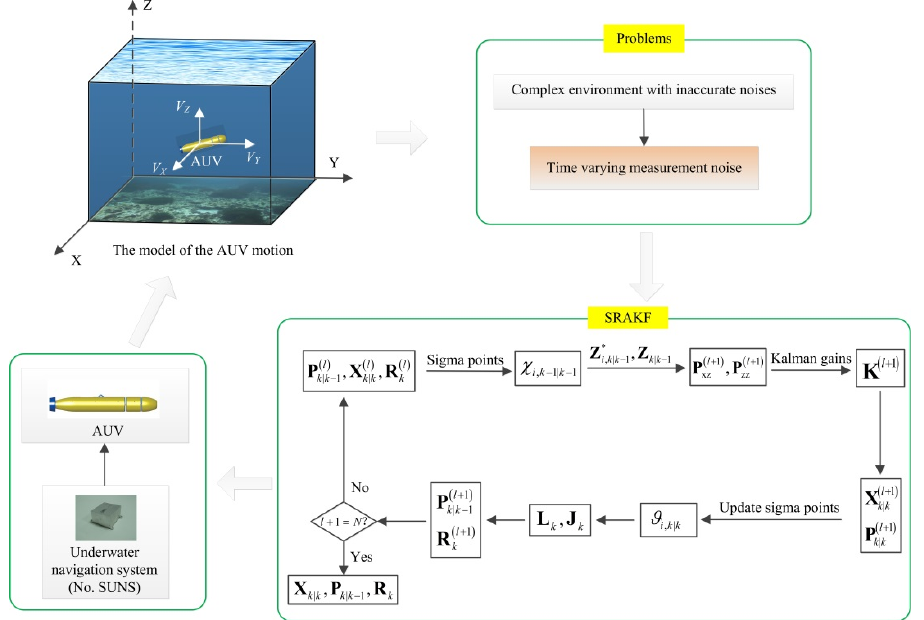
Figure 5. The flowchart of the proposed SRAKF.